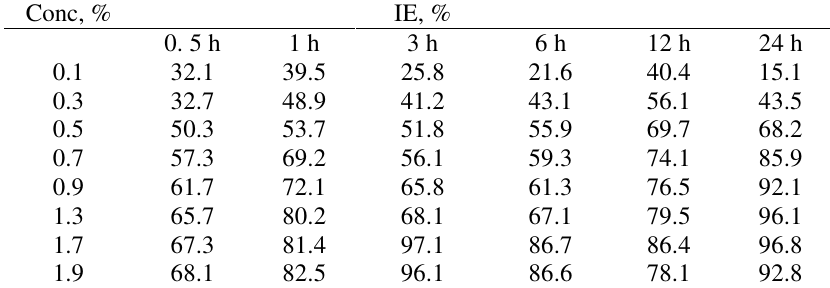
Table 1. Inhibition efficiency as a function of immersion time and concentration